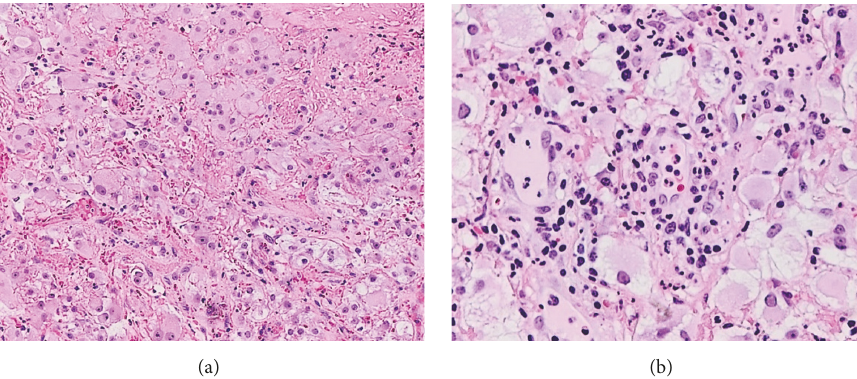
Figure 2: Histology of recurrent vaginal mass. (a) The clear cell renal cell carcinoma showing areas of inflammation and extensive rhabdoid differentiation (H&E, × 100). (b) High power view of the rhabdoid cells observed in the recurrent vaginal excision (H&E, × 200).